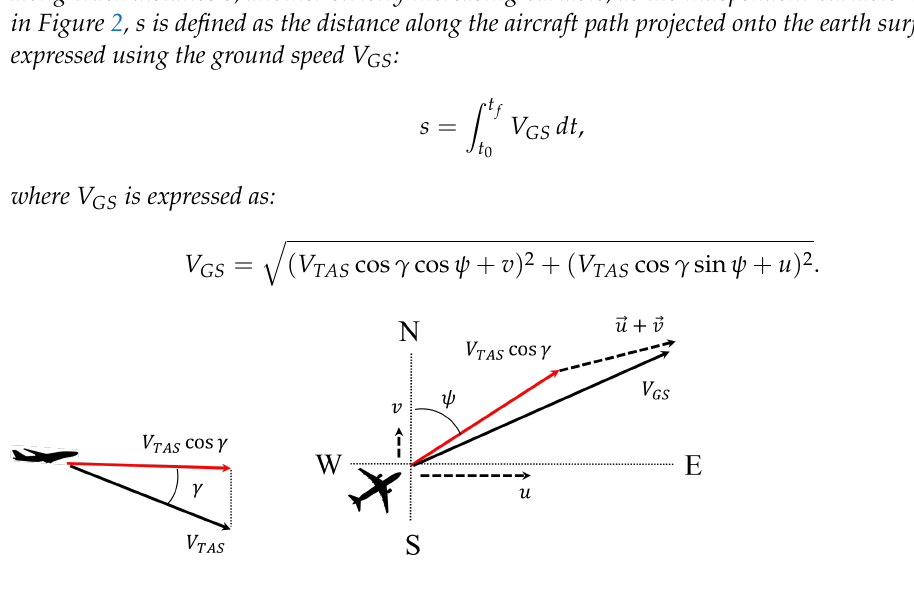
Figure 2. Relationship between the true air speed V TAS and the ground speed V GS